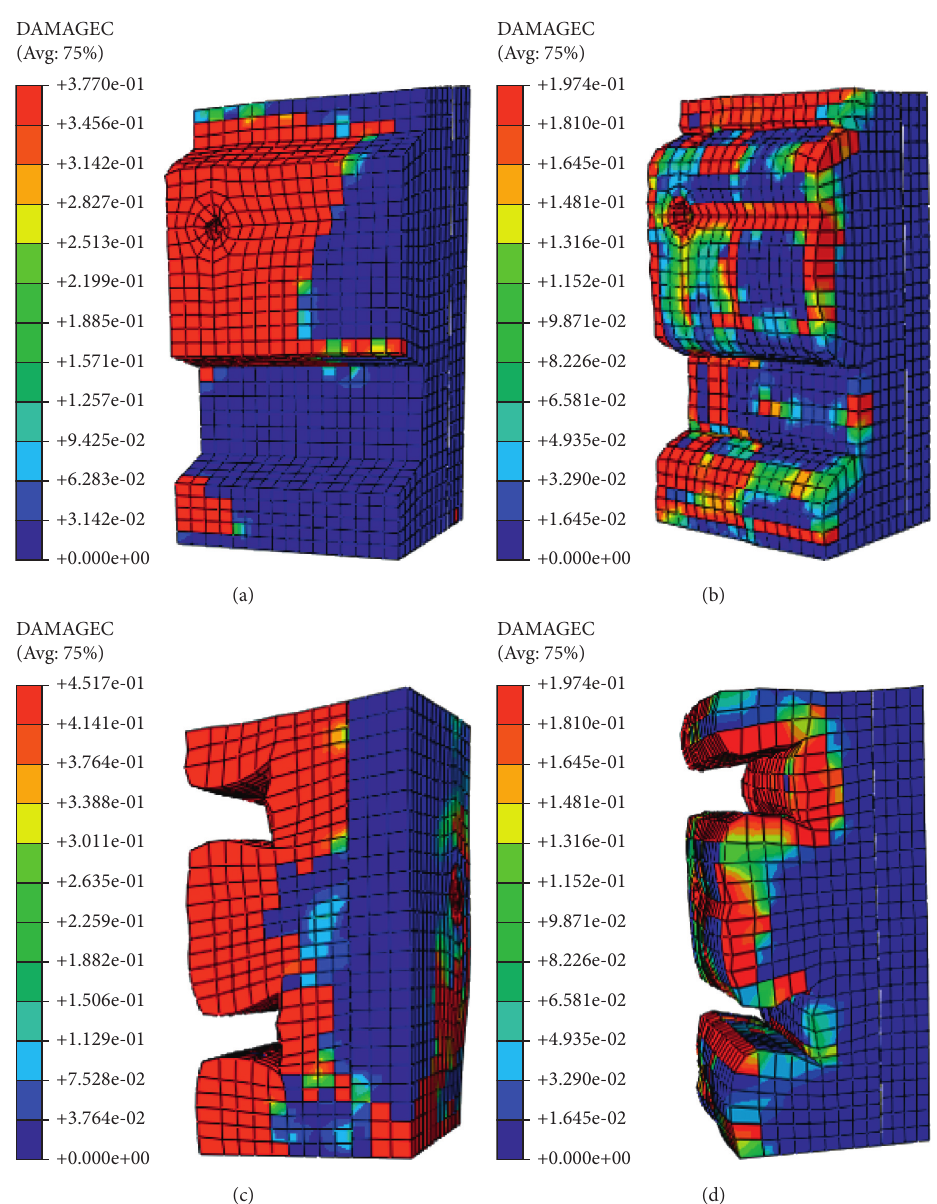
Figure 13: Damage mode of concrete cone slab within open trough (a, b) and reentrant (c, d) profiled steel sheeting